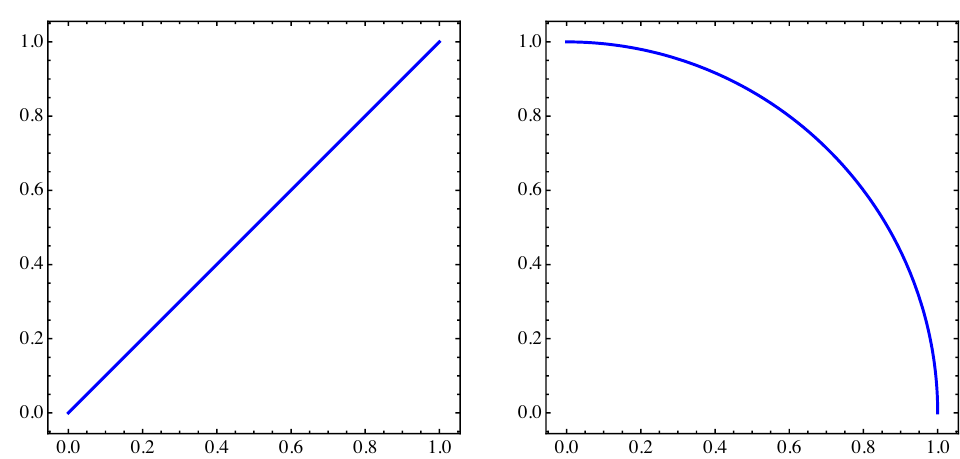
Figure 6. Pareto set (left) and front (right) of MOP (12) for n = 2 with γ =